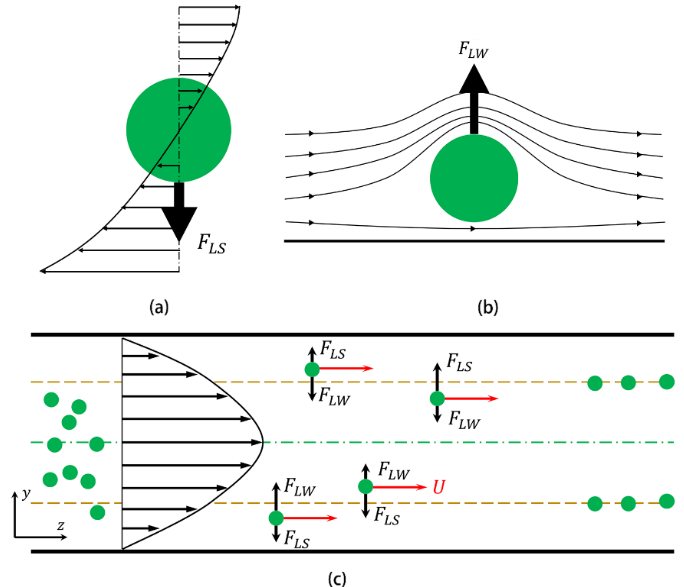
Figure 4. ( a ) Flow field of F LS ; ( b ) Flow field of F LW ; ( c ) Flow field distribution in channel and inertial-lift-force schematic diagram.